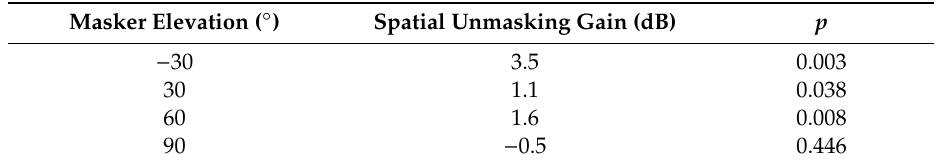
Figure 1. Signal-to-noise ratio (SNR) for 50% correct speech reception as a function of the elevation angle of the masker. The plots represent the mean average of SNRs obtained from six subjects and one standard error. Table 2. Spatial unmasking gain on speech reception thresholds (SRTs): p values obtained from Bonferroni-corrected t tests. The gain is defined as mean difference of 0° from each masker position.